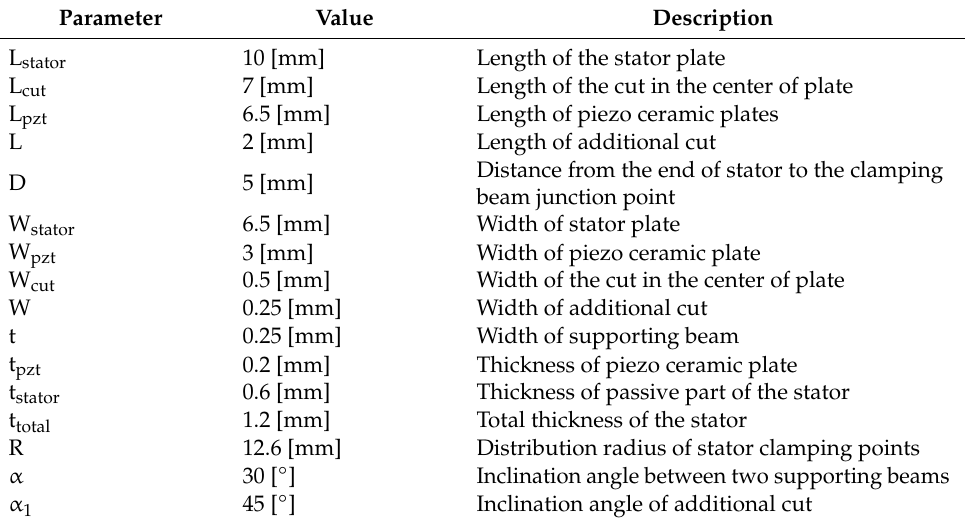
Table 1. Geometrical parameters of the